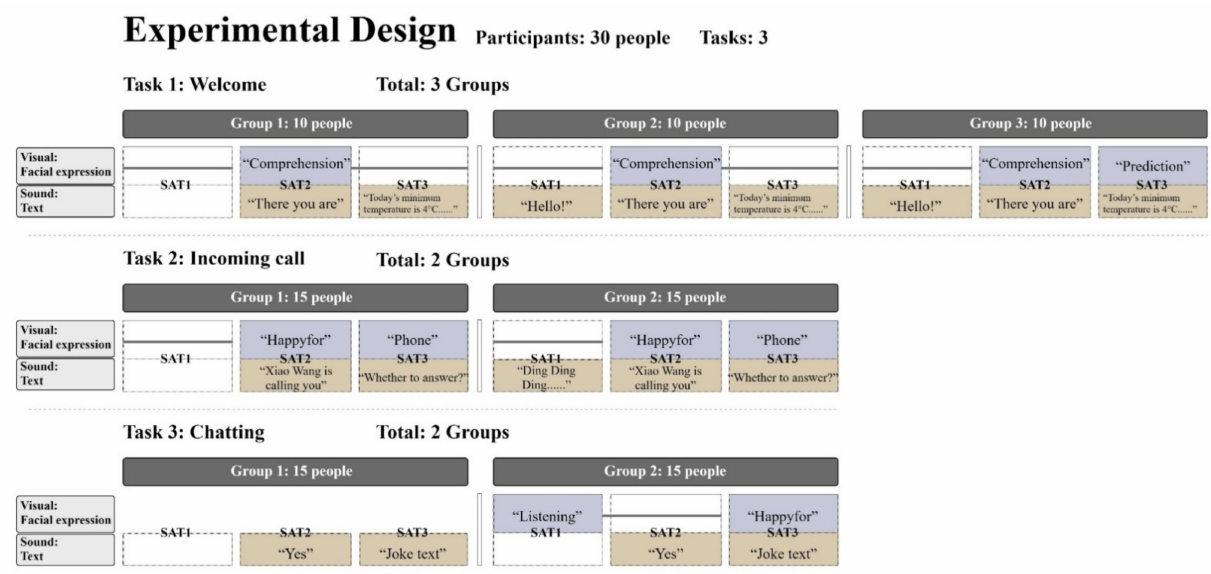
Figure 1. Different information transparency and anthropomorphic designs for the three